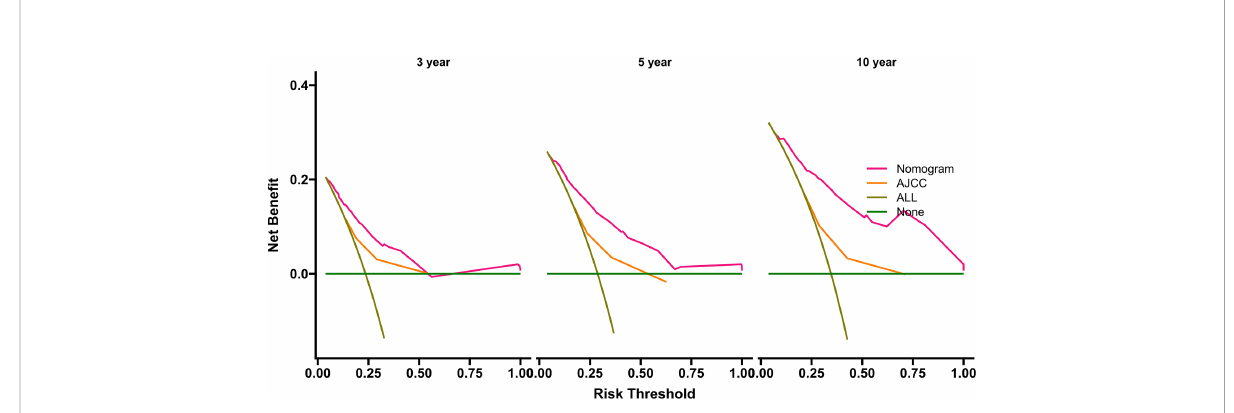
FIGURE 5 Decision curve analyses for survival at 3, 5, and 10 years using the nomogram compared with AJCC data in the internal-validation group. AJCC, American Joint Committee on